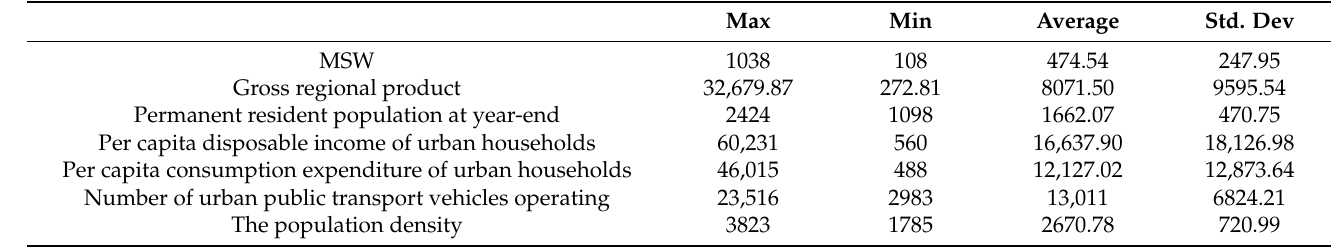
Table 2. Six indicator